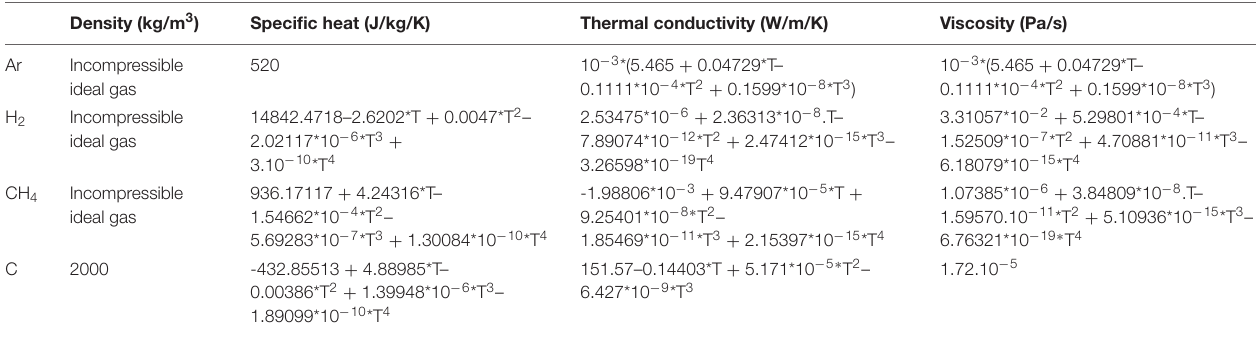
TABLE 2 | Main properties of